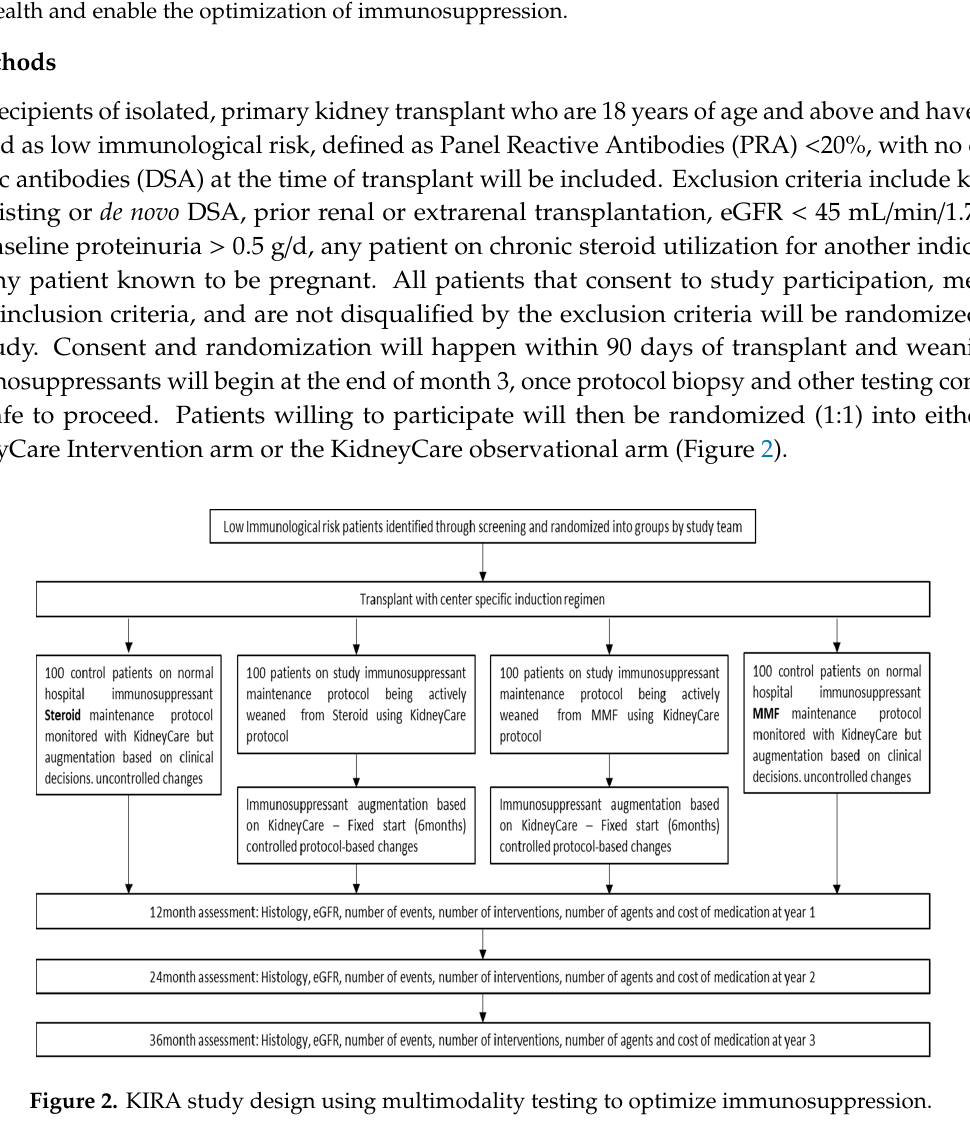
Figure 2. KIRA study design using multimodality testing to optimize immunosuppression.